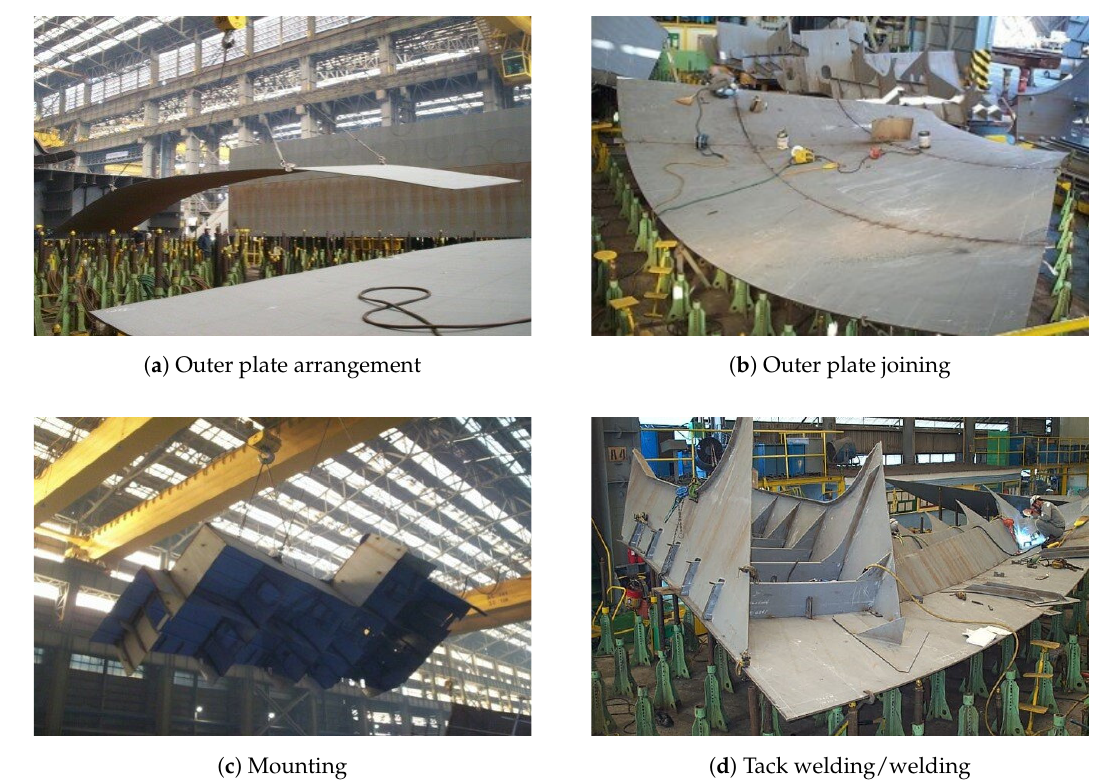
Figure 1. Working activities in the curved block assembly